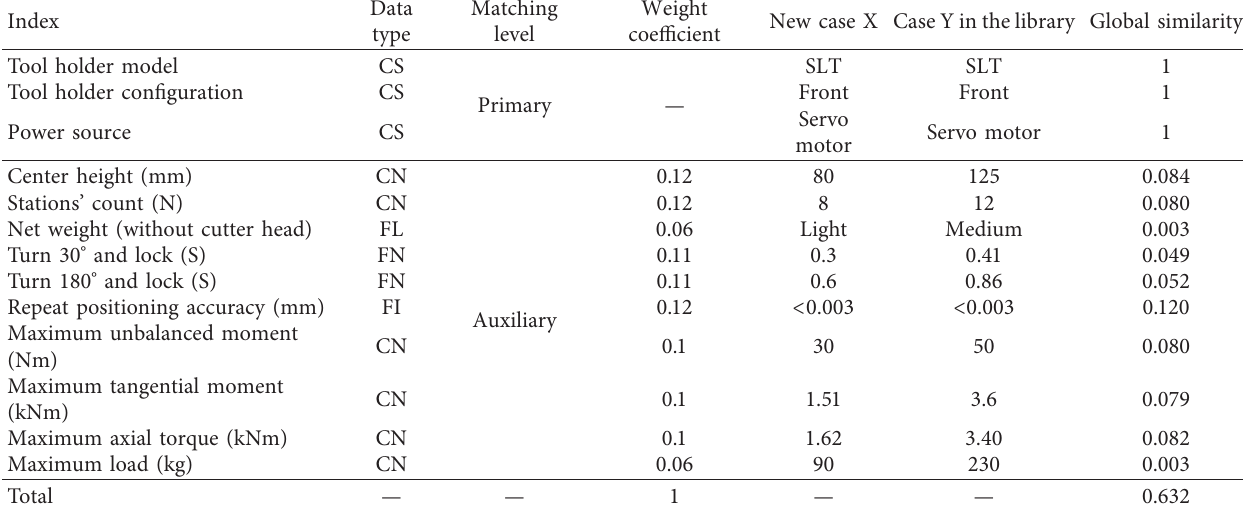
Table 3: Similarity measurement of the performance requirements of the CNC tool